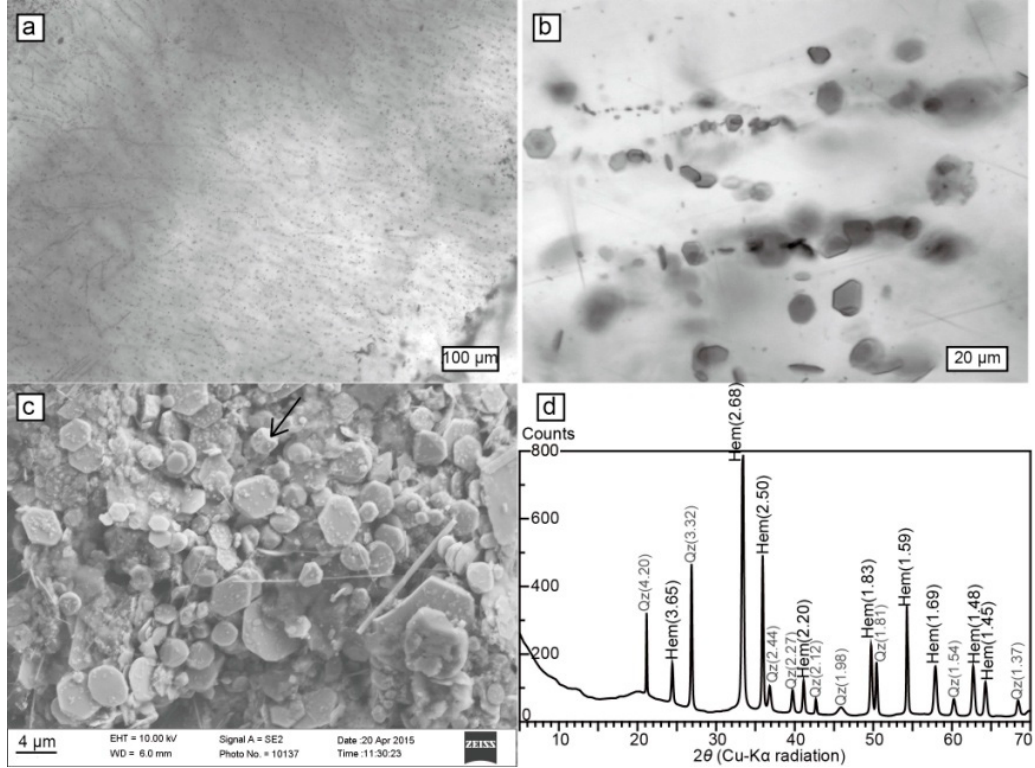
Figure 6. Photomicrographs and X-ray diffraction (XRD) analysis of hematite crystals from core RS2.6, 154 m. ( a ) Microcrystalline hematite incorporated within halite; ( b ) hematite crystals are 1–10 μ m hexagonal plates; ( c ) scanning electron microscopy (SEM) image of the hematite crystals. All the hexagonal plates are hematite; crystals with trigonal pattern (arrow) are quartz; ( d ) XRD result of insoluble residue following dissolution of halite in water. Numbers in the parentheses are d-spacings in Å of Qz: quartz and Hem: hematite.